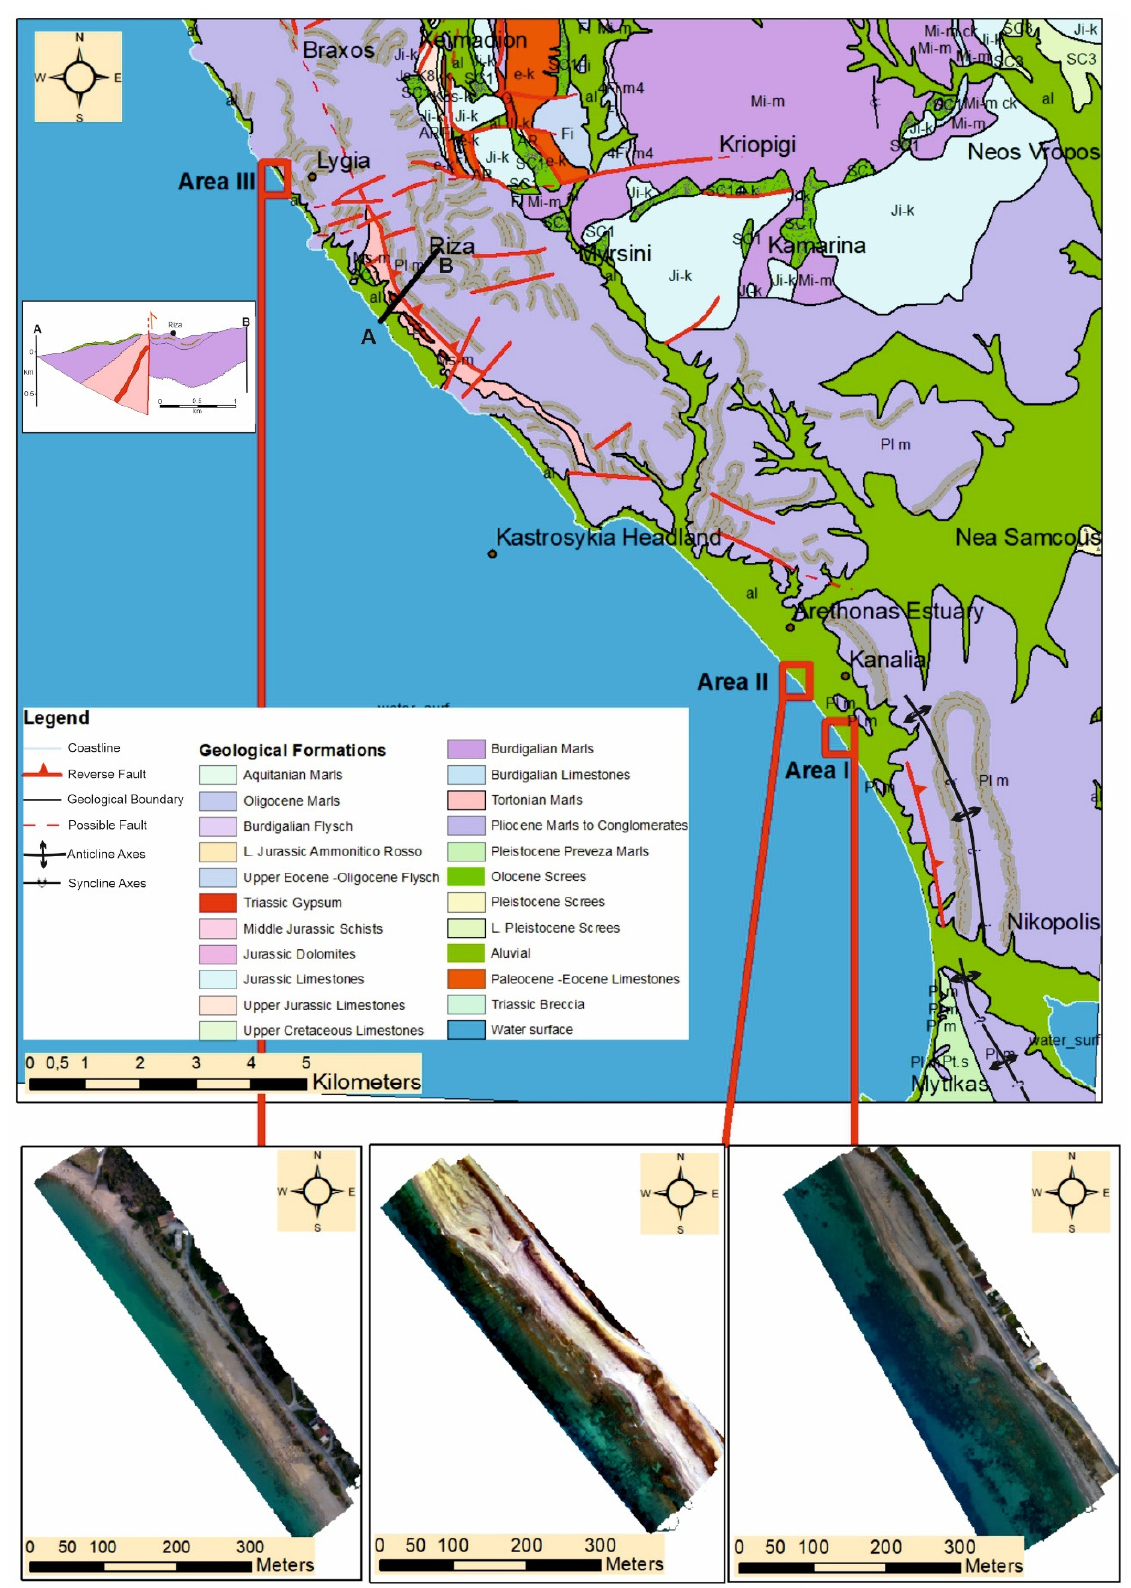
Figure 2. The geological map of the broader area and three insets in the lower part presenting orthophoto of each study area. The cross section AB presents a major reverse fault in the study area. The geological map and the cross section are modified from [50].